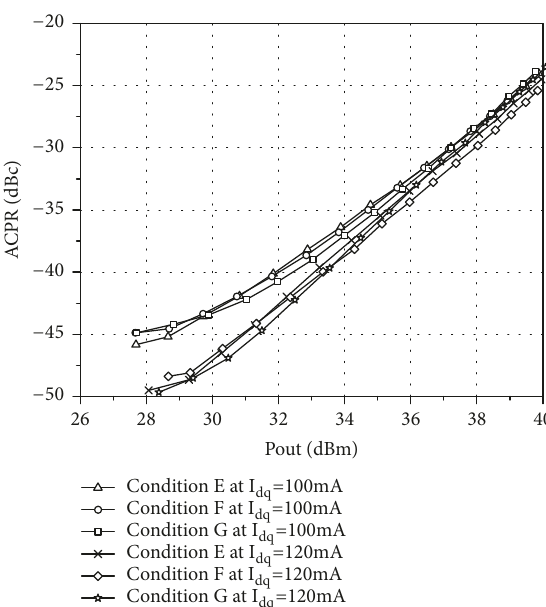
Figure 9: Gm of different device.